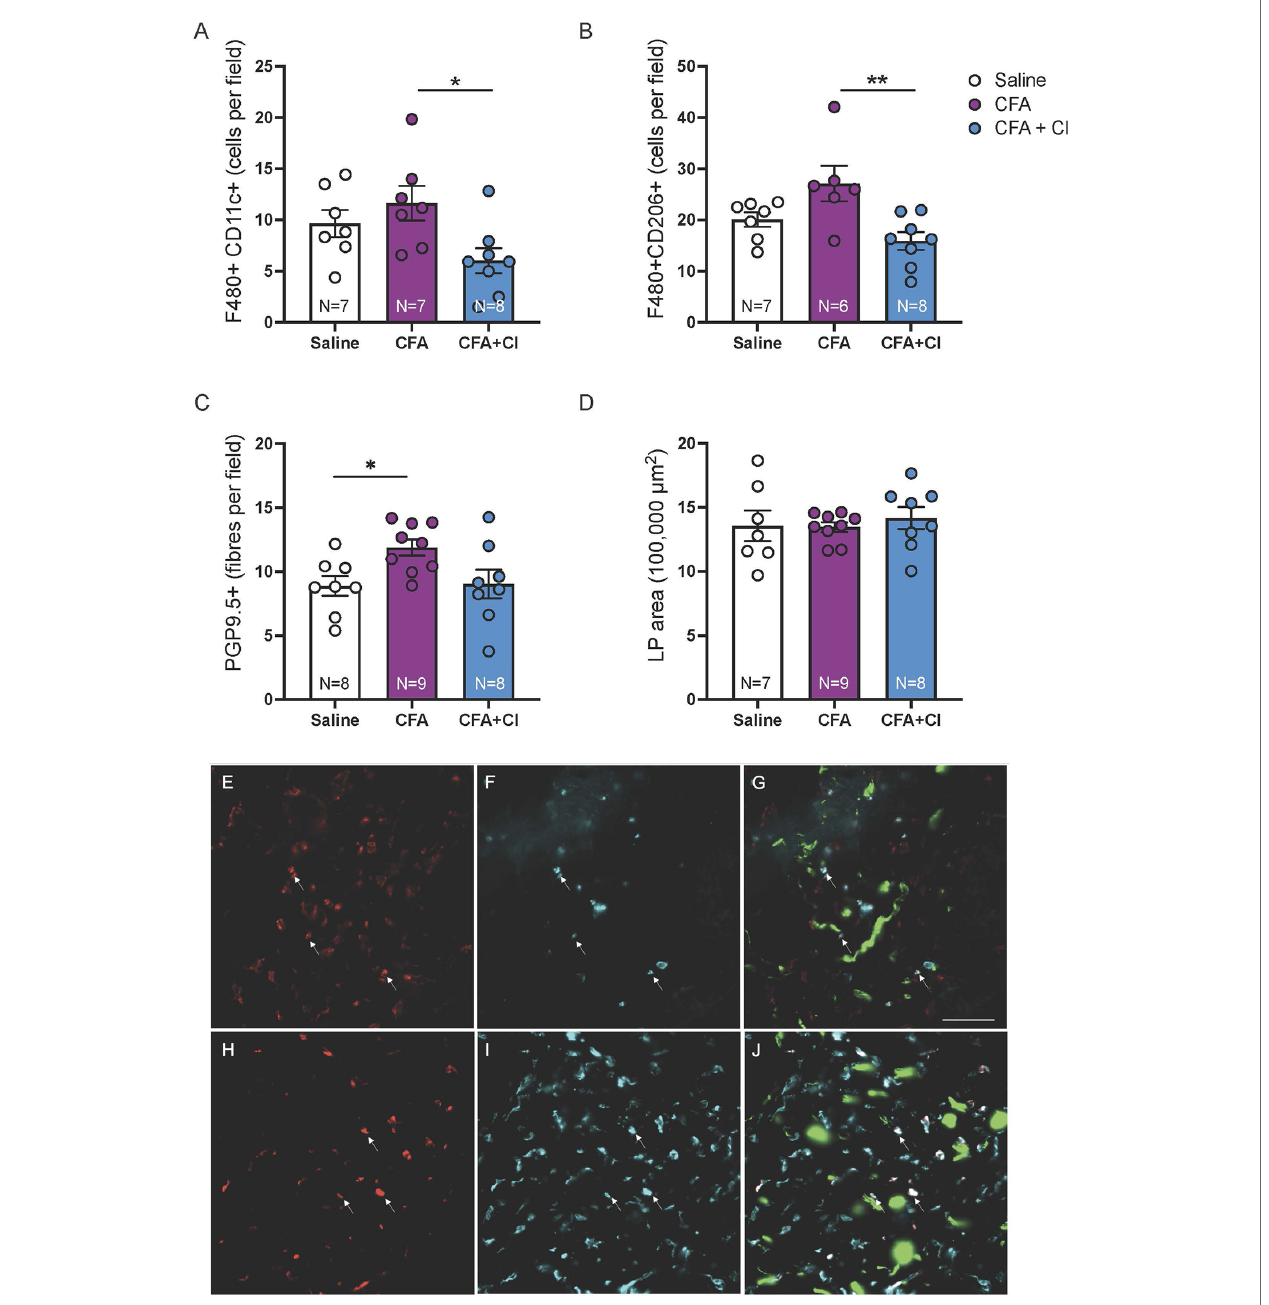
FIGURE 1 | Clodronate treatment depleted vaginal macrophages in the CFA mouse model of vulvodynia. (A) Putative M1 macrophages were identi fi ed less frequently in F480/CD11c-immunolabelled vaginal sections from mice that received CFA and were treated with clodronate (*p < 0.05, ANOVA: F (2,19) = 4.20, p = 0.03, control saline 9.6 ± 1.3; CFA 11.6 ± 1.6; CFA + clodronate 6.0 ± 1.2). (B) Similarly, putative M2 macrophages, identi fi ed by immunolabelling for F4/80 and CD206, were found less frequently in sections from mice that were treated with clodronate (**p < 0.01, ANOVA: F (2,18) = 6.37, p = 0.008, control saline 20.1 ± 1.4; CFA 27.1 ± 3.5; CFA + clodronate 15.9 ± 1.7). (C) The number of nerve fi bres immunoreactive for the pan-neuronal marker PGP9.5 was higher in mice that received CFA compared to control mice (*p < 0.05) but not signi fi cantly reduced in mice treated with clodronate (ANOVA: F (2,22) = 4.10, p = 0.03; control saline 8.9 ± 0.8; CFA 11.9 ± 0.6; clodronate: 9.0 ± 1.1, N = 8 per group). (D) Comparison of vaginal cross-sectional lamina propria (LP) area indicated no evidence of swelling (oedema) in any group one week following administration of CFA with or without clodronate (ANOVA: F (2,23) = 0.045, p = 0.96, N = 7 – 9 per group). (E – G) Example images of putative M1 macrophages labelled with F4/80 (E) and CD11c (F) and overlay image (G) showing F4/80+CD11c+ cells (arrows) plus nerve fi bres (green) immunoreactive for PGP9.5. (H – J) Example images of putative M2 macrophages labelled with F4/80 (H) and CD206 (I) and overlay image (J) showing F4/80+CD206+ cells (arrows) and PGP9.5-IR nerve fi bres (green). These images are from a mouse that received CFA. Scale bar = 50